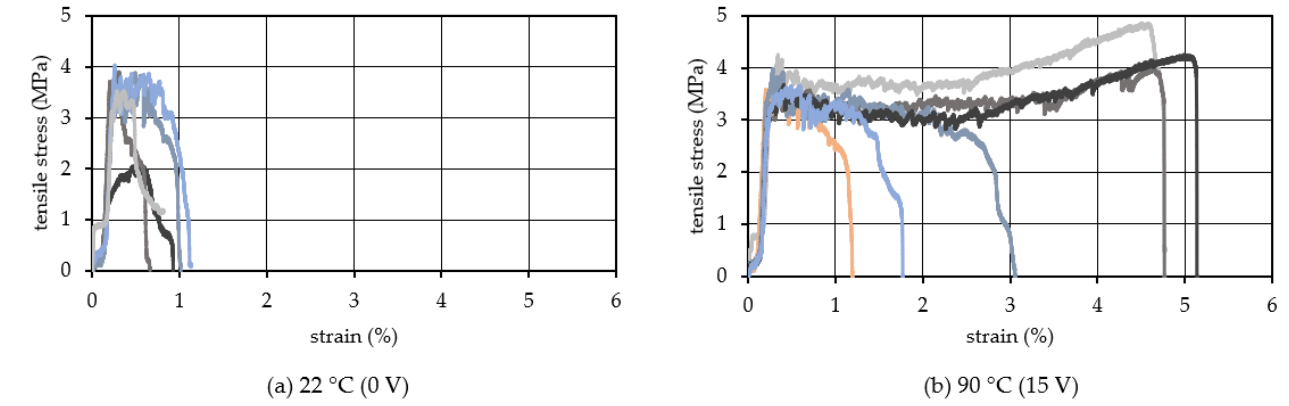
Figure 7. Tensile stress − strain relationship (Vf: 1.75 vol.%).